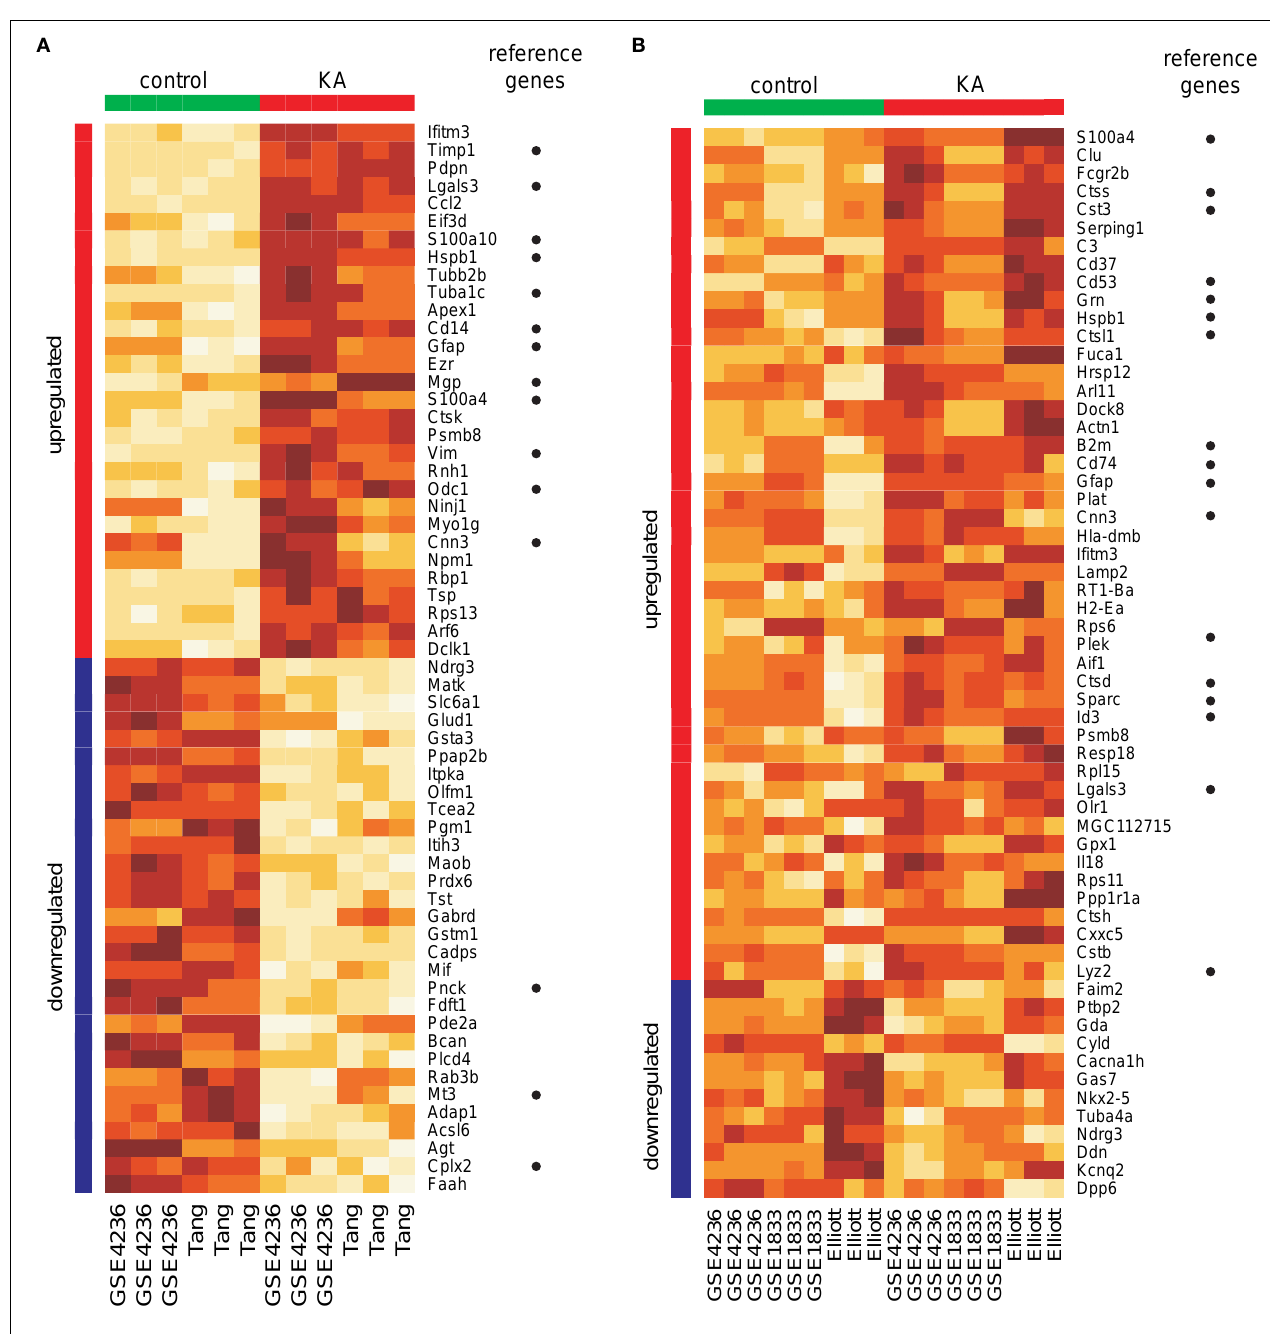
down-regulated). Colour bars on the top indicate control (green) and treated (red) samples. The columns correspond to samples and are labelled by the name of the dataset they are coming from. The colours in the heatmap indicate the relative level of expression (light brown for low expression and dark brown for high expression). The expression values for each gene were normalized to have mean 0 and variance 1 to facilitate comparison between